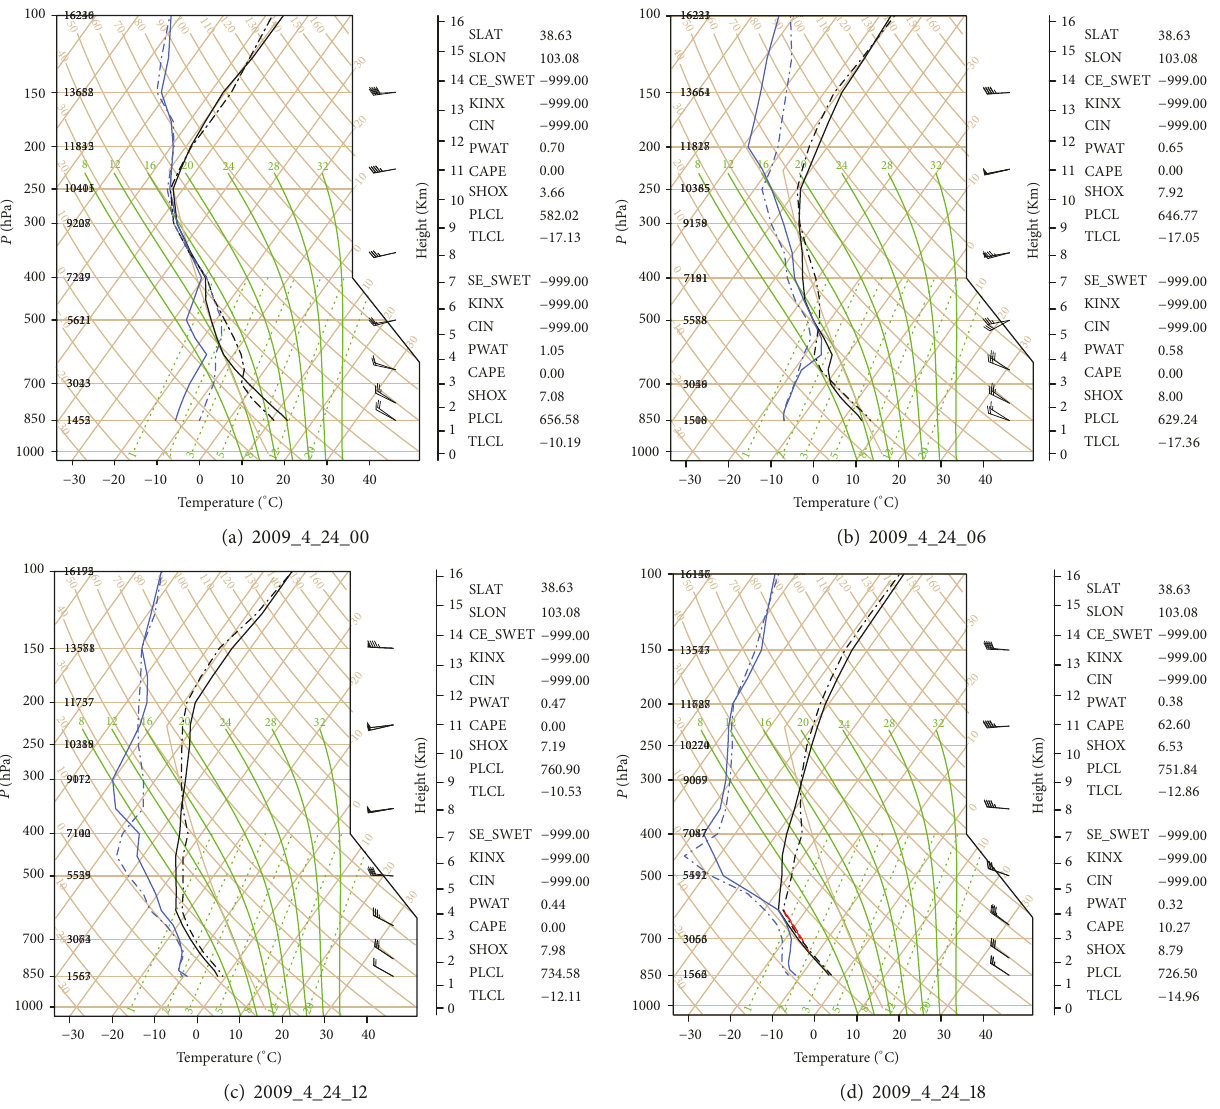
Figure 7: The atmospheric stratification curve at (a) 00:00, (b) 06:00, (c) 12:00, and (d) 18:00 (UTC) on April 24, 2009, in Minqing in China (42.5 ∘ N, 87.5 ∘ E) (solid line: CE; dotted line: